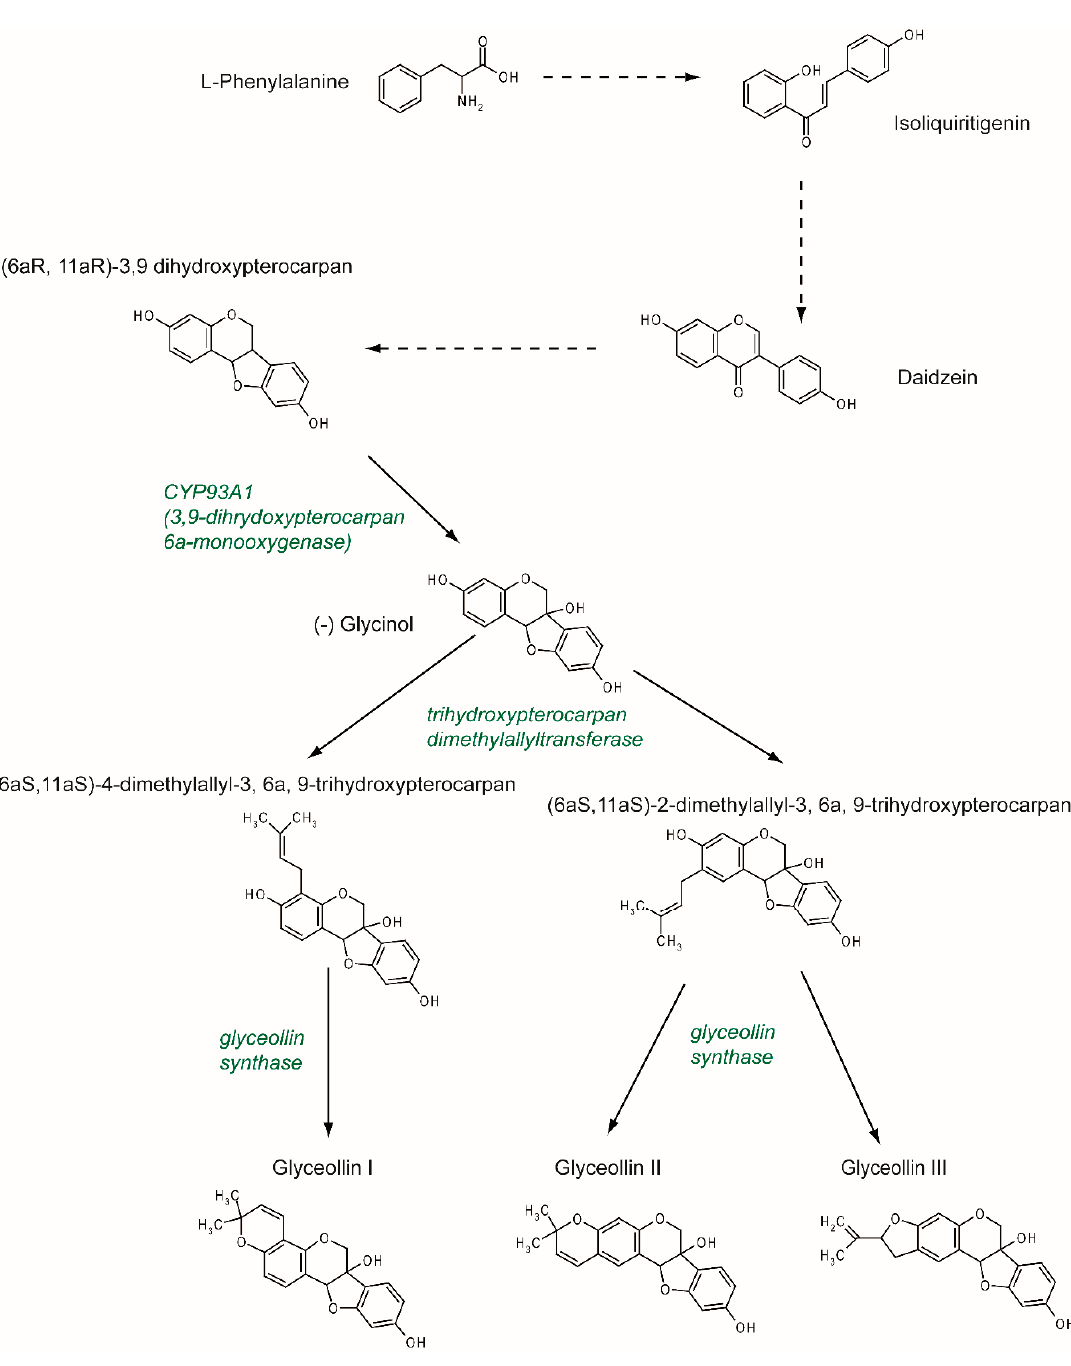
Figure 2. Glyceollin biosynthesis pathway. The isoflavone daidzein serves as the metabolic precursor for the rapid production of glyceollins. Daidzein is produced through the isoflavonoid branch of the phenylpropanoid pathway starting from L-phenylalanine. Under stress, daidzein is transformed into (6aR, 11aR)-3,9 dihydroxypterocarpan. This molecule is metabolized by CYP93A1 into (-) glycinol.